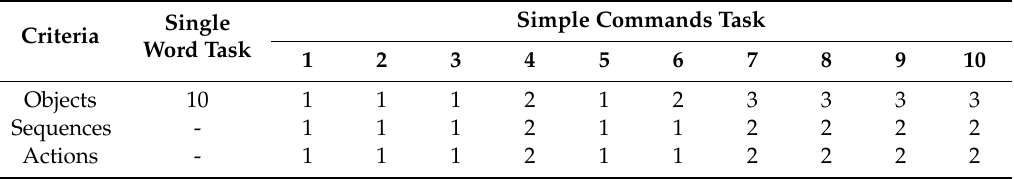
Figure 6. Comprehension performance of the Anomic and Wernicke’s subjects. ( a ) Average accuracy of single word comprehension; ( b ) object identification accuracy in commands; ( c ) sequence accuracy in commands; ( d ) action identification accuracy in commands. Table 4. Comprehension task summary (number of objects, sequences, and actions to